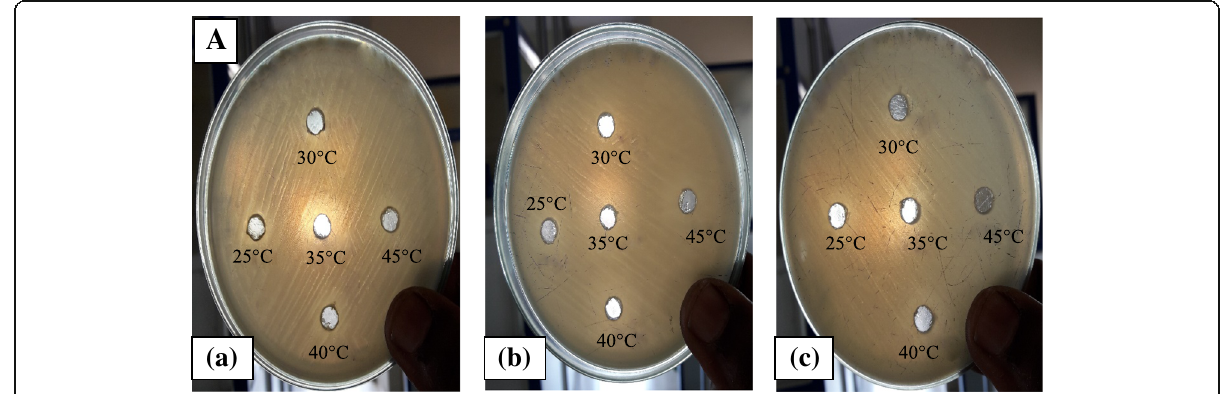
Fig. 1 A Effect of temperature on bacteriocin production after 24 h against (a) P. aeruginosa , (b) S. aureus , and (c) E.coli